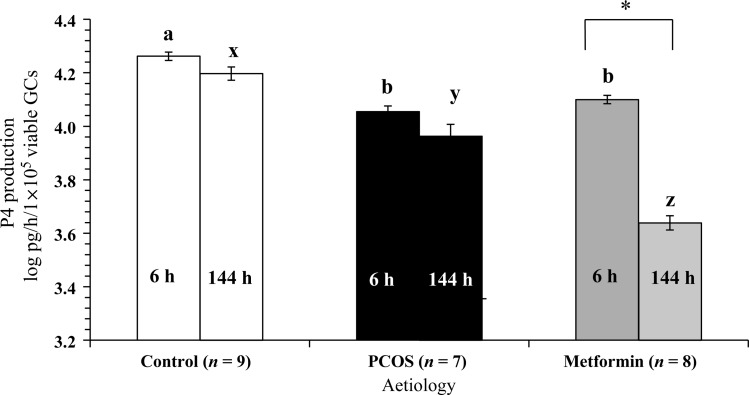
The effects of aetiology and duration of culture on overall progesterone production by GCs. The values plotted are mean ± SEM of the log-transformed data for the number of individual patient cultures shown. Data have been standardized according to viable cell number. a and b indicate significant difference (P < 0.05) between the aetiological groups at 6 h of culture (6 h) and x, y and z indicate significant difference (P < 0.05) between the aetiological groups at 144 h of culture (144 h). Asterisk indicates significant difference (P < 0.05) within aetiology at the two time points shown.